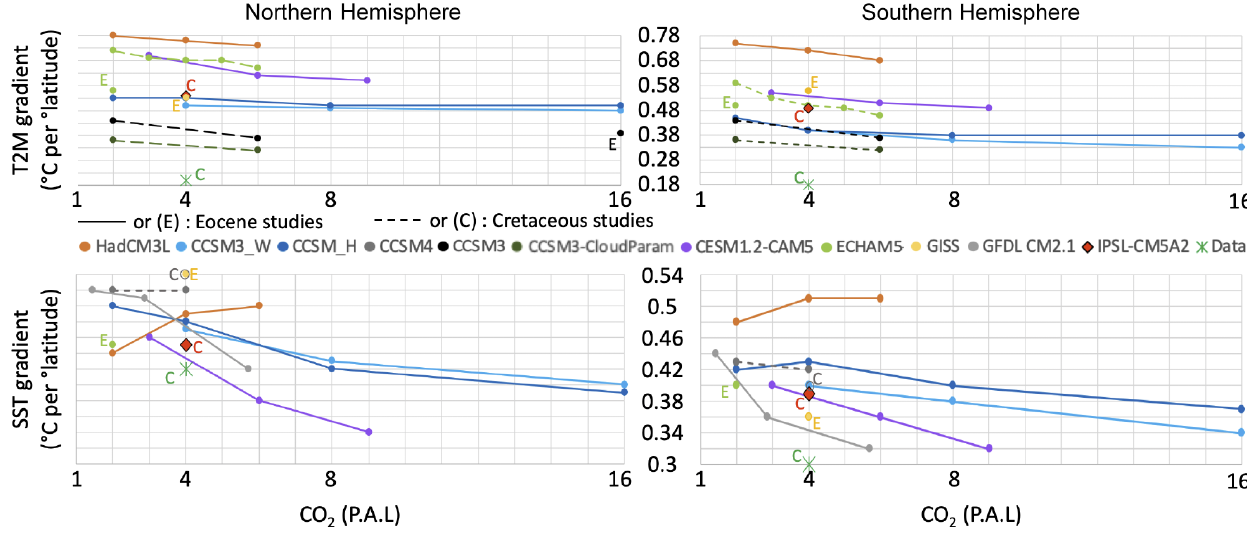
Figure 11. Plot of atmospheric and sea-surface mean annual temperature gradients vs. p CO 2 for different modelling studies and data compilation. Data gradients are plotted for a default p CO 2 value of 4PAL. Gradients are expressed in degrees Celsius per degree latitude ( ◦ C per ◦ latitude) and are calculated from 30 to 80 ◦ of latitude. Gradients linked by a line correspond to studies realized with the same model & palaeogeography. Solid lines or gradients marked with a (E) correspond to an Eocene palaeogeography. Dashed lines or gradients marked with a C correspond to a Cretaceous